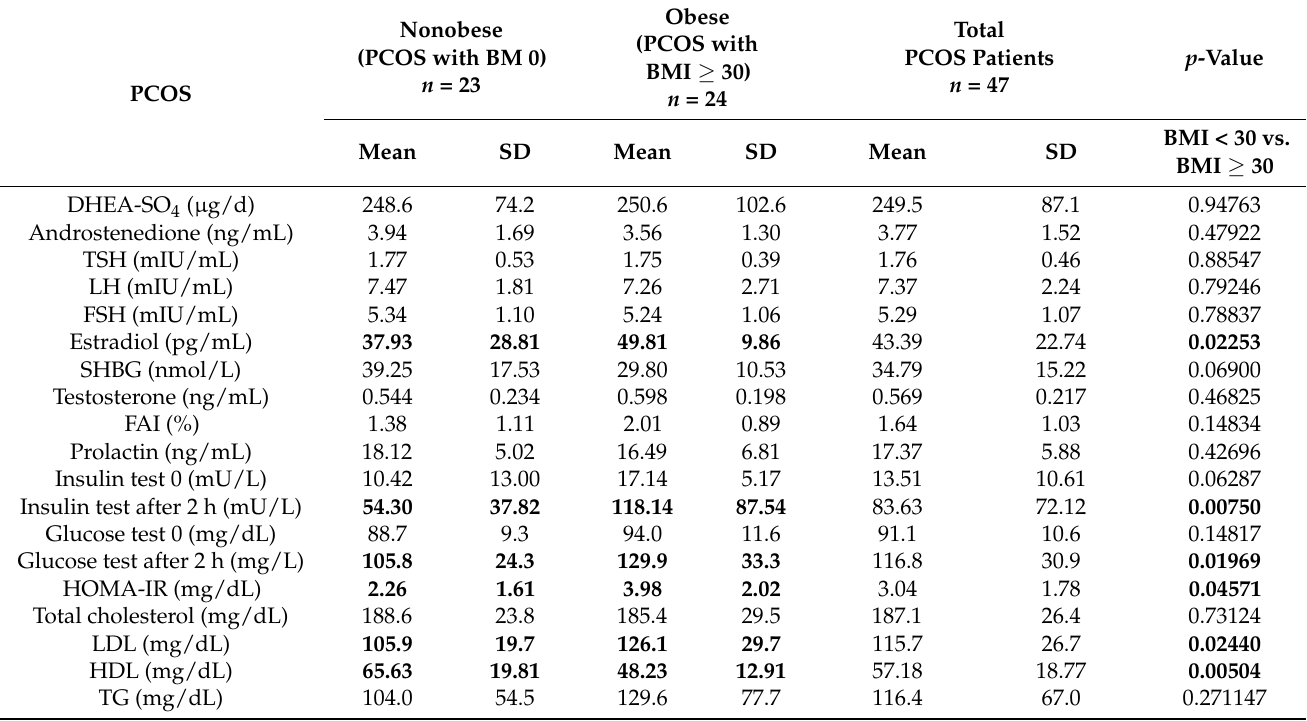
Table 2. Biochemical differences between nonobese (BMI < 30) and obese (BMI ≥ 30) PCOS